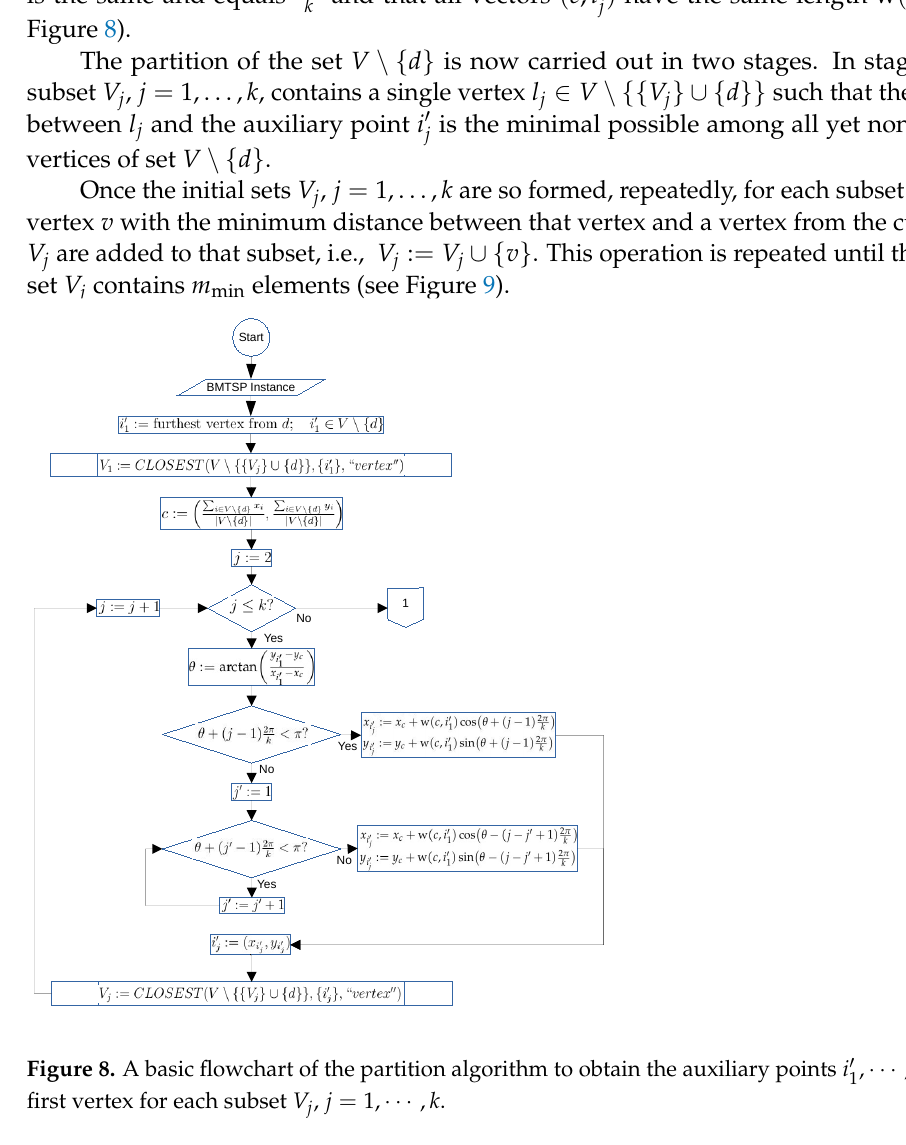
, · · · , i (cid:48) and 1 k